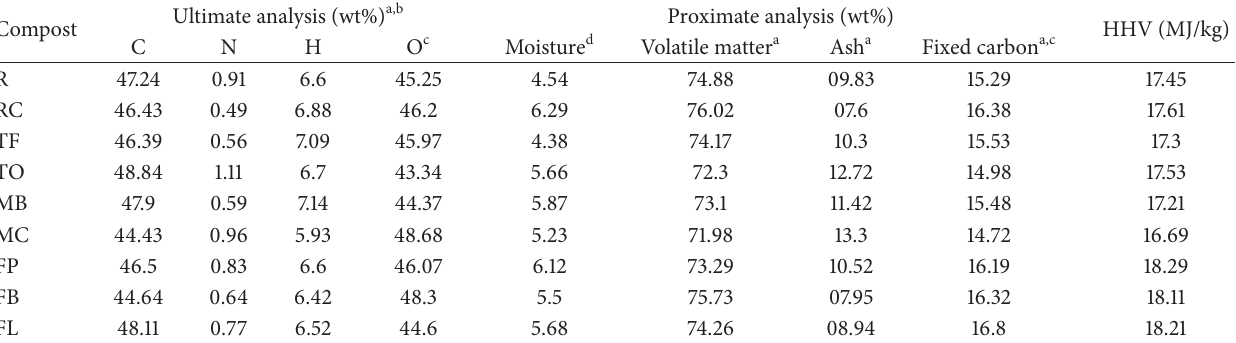
Table 2: Proximate and ultimate analyses of